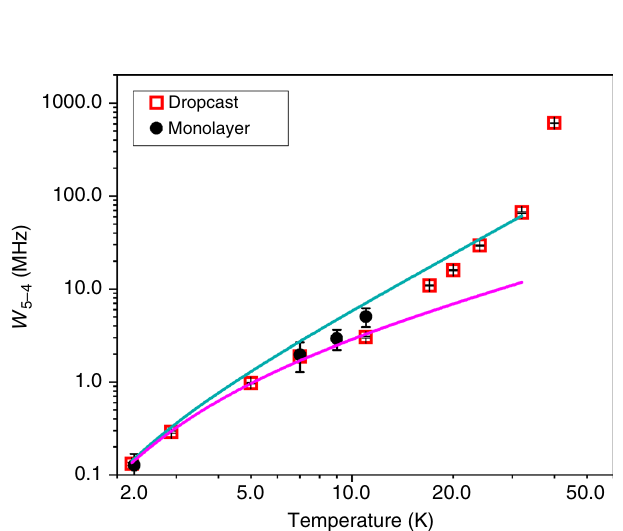
Fig. 4 Spin dynamics in the dropcast and monolayer samples. Transition rate W 5 − 4 between the states M S = ± 5 and M S = ± 4 extracted from the fi ts of the Mössbauer spectra of the dropcast sample (red squares) and of the monolayer sample (black dots) as a function of temperature. The magenta line represents the fi t of the data for the dropcast sample at T ≤ 11 K assuming a direct process as in Eq. (4), while the cyan line corresponds to the more general function reported in Eq.